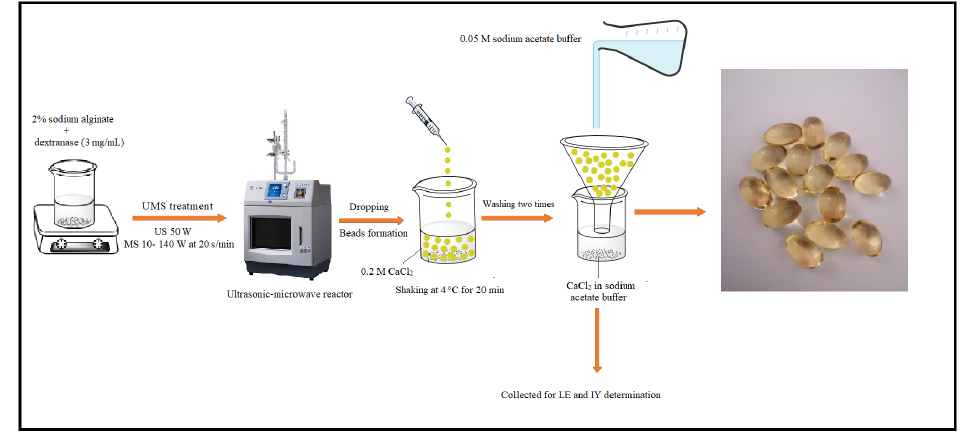
Figure 8. Preparation of the immobilized enzyme with ultrasonication–microwave shock treat- ment.